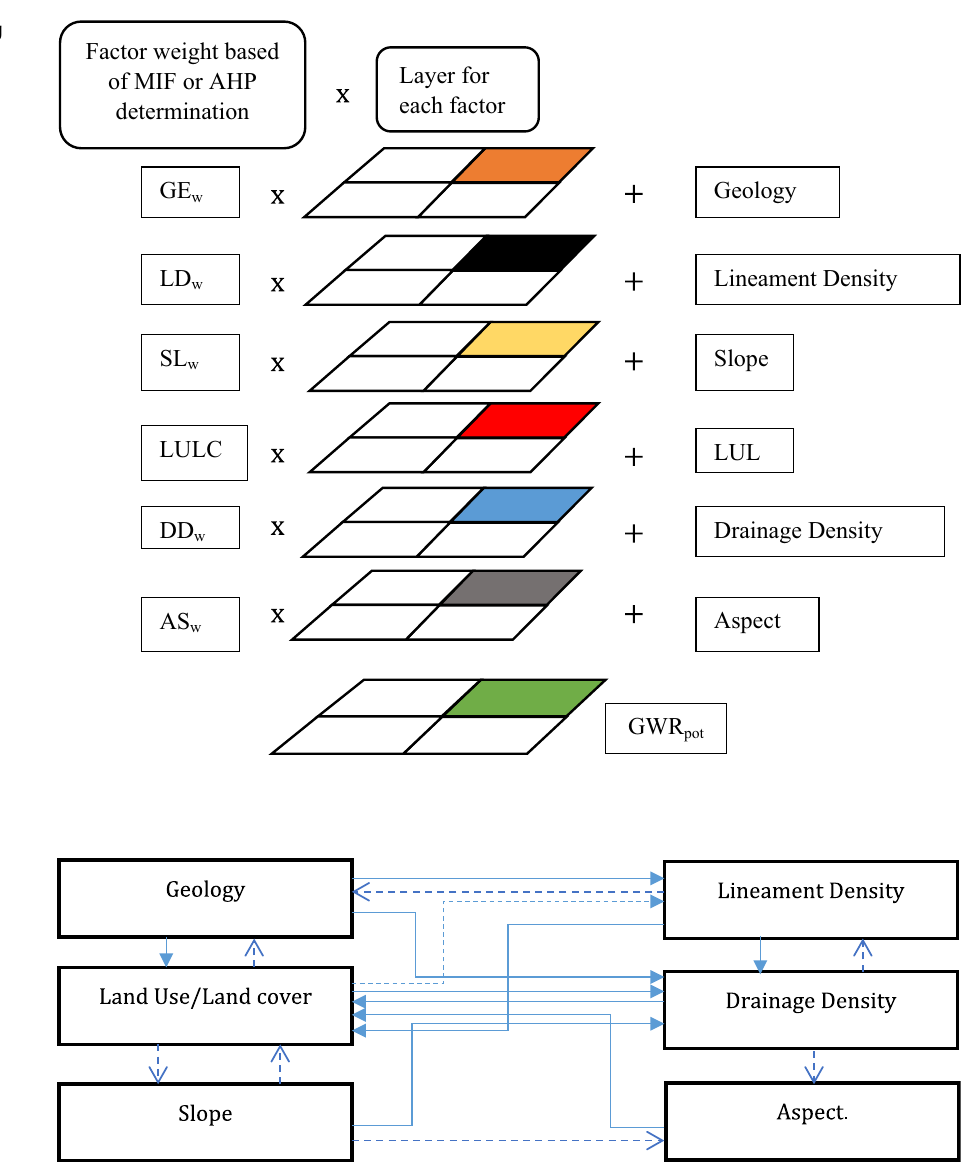
Fig. 3 Integrating factors using superposition principle of weighted overlay analysis to produce GWR map of study pot area